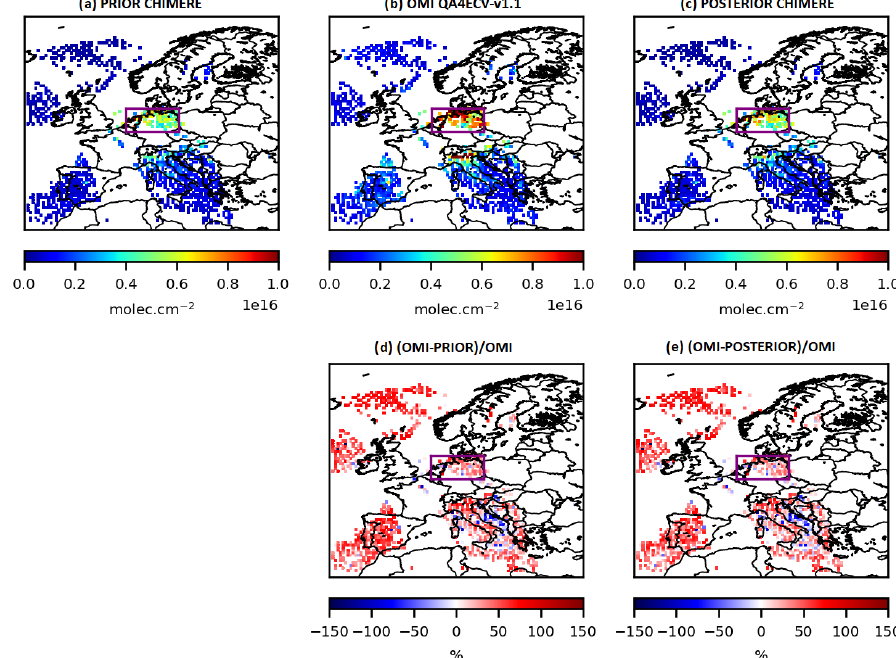
Figure 6. NO 2 collocated tropospheric columns (a) simulated by CHIMERE using the prior TNO-GHGco-v1 emissions and the climatolog- ical values from the LMDZ-INCA global model for initial and boundary conditions, (b) observed by OMI and (c) simulated by CHIMERE using the posterior emissions, in 10 16 molec.cm − 2 , at the 0.5 ◦ × 0.5 ◦ grid-cell resolution, for 19 February 2015. Relative differences be- tween OMI and (d) the prior CHIMERE simulation or (e) the posterior CHIMERE simulation, in %. Statistics for the comparison between simulations and observations are given in Table 5 for the area in the purple box. Table 3. Description of the different sensitivity tests performed for the construction of the B matrix for the NO x inversion. Prior error standard deviations in